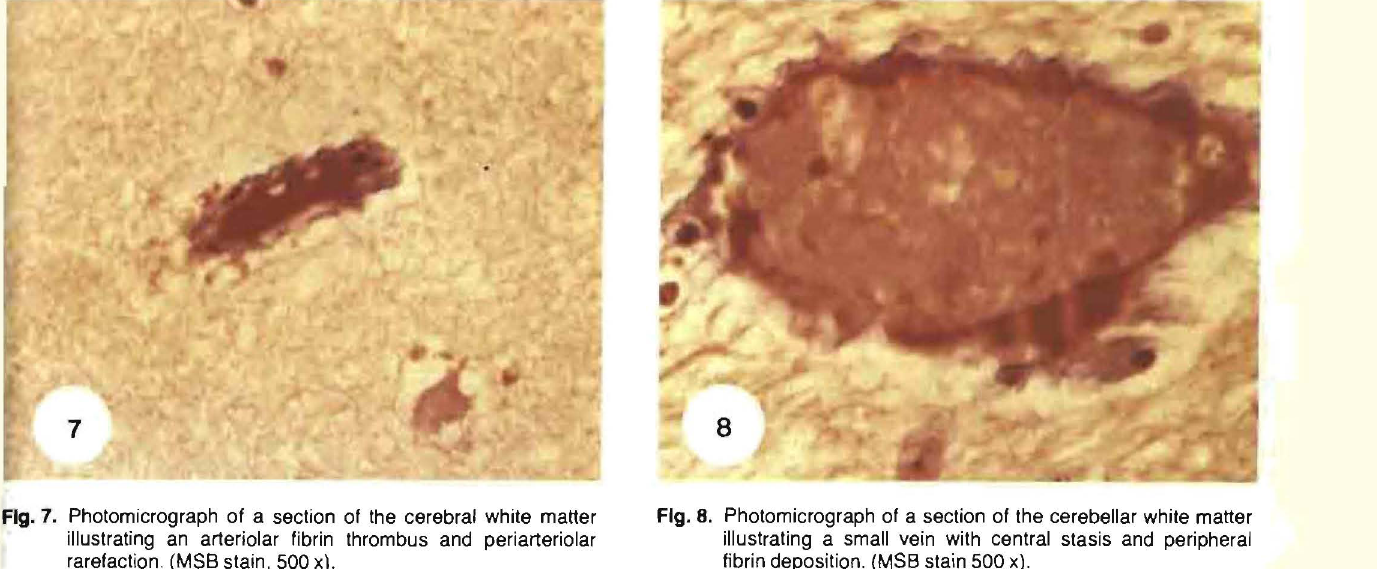
Fig. 7. Photomicrograph of a section of the cerebral white matter illustrating an arteriolar fibrin thrombus and peri arteriolar rarefaction. (MSB stain, 500 x).